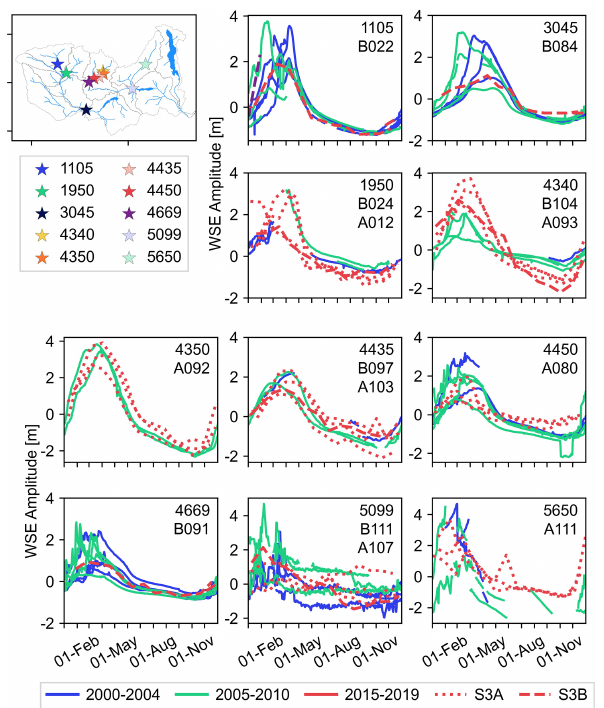
Figure 6. Comparison between in situ annual water surface eleva- tion (WSE) and satellite WSE at 10 virtual stations in the Zambezi basin. The colors indicate the time of observation. All elevations are referenced to the long-term average WSE to avoid bias due to the vertical datum. Stations 4340–4669 are all located on the Kafue in close